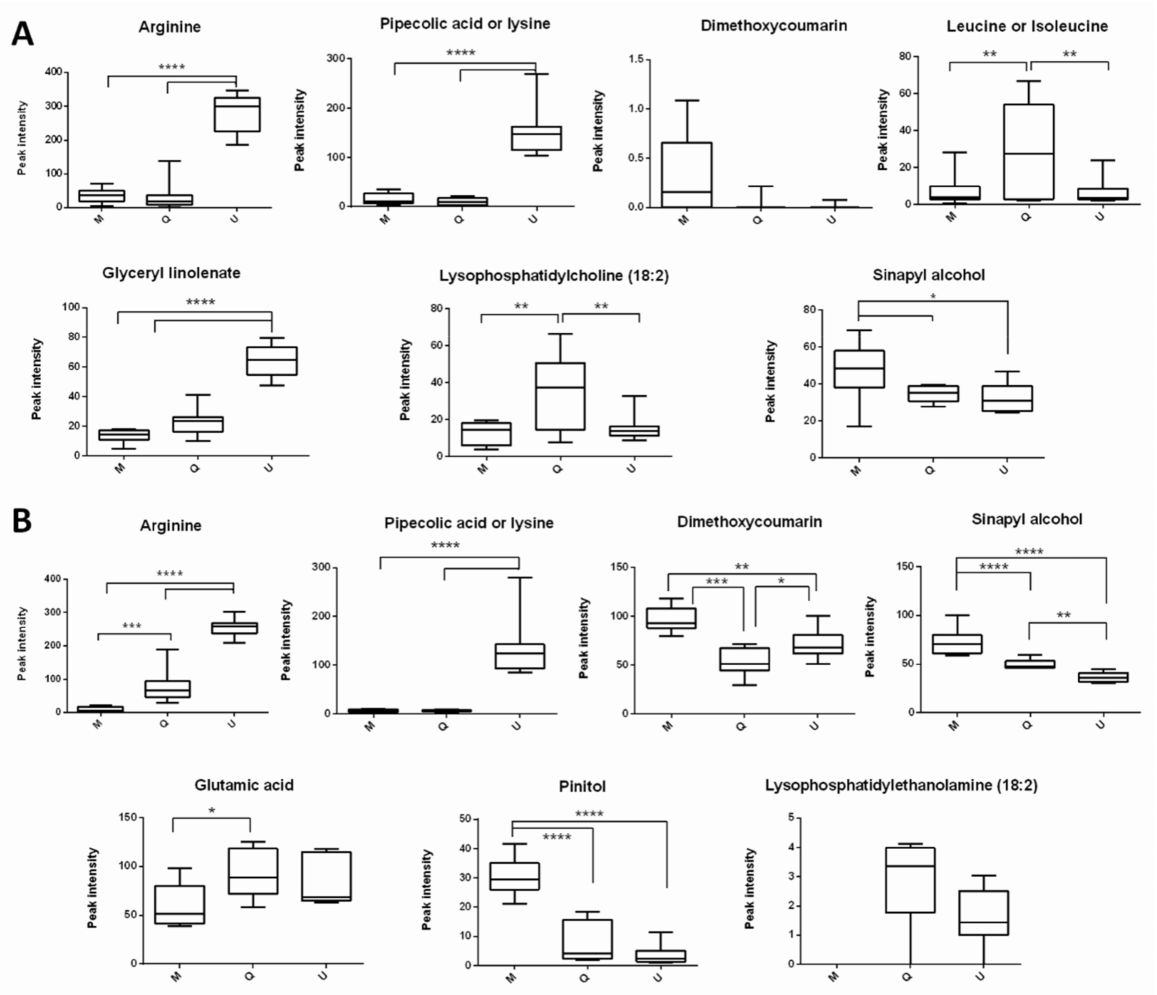
Figure 3. Intensity of the 2016 ( A ) and 2017 ( B ) VIP scores of Viscum album ssp. album from different host trees. M: V. album from Malus domestica , Q: V. album from Quercus robur , U: V. album from Ulmus carpinifolia